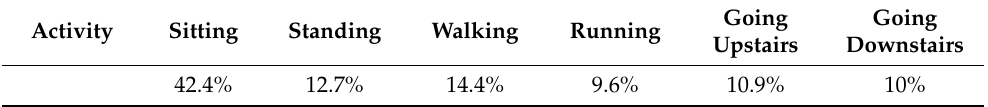
Table 1. Activities of our dataset.